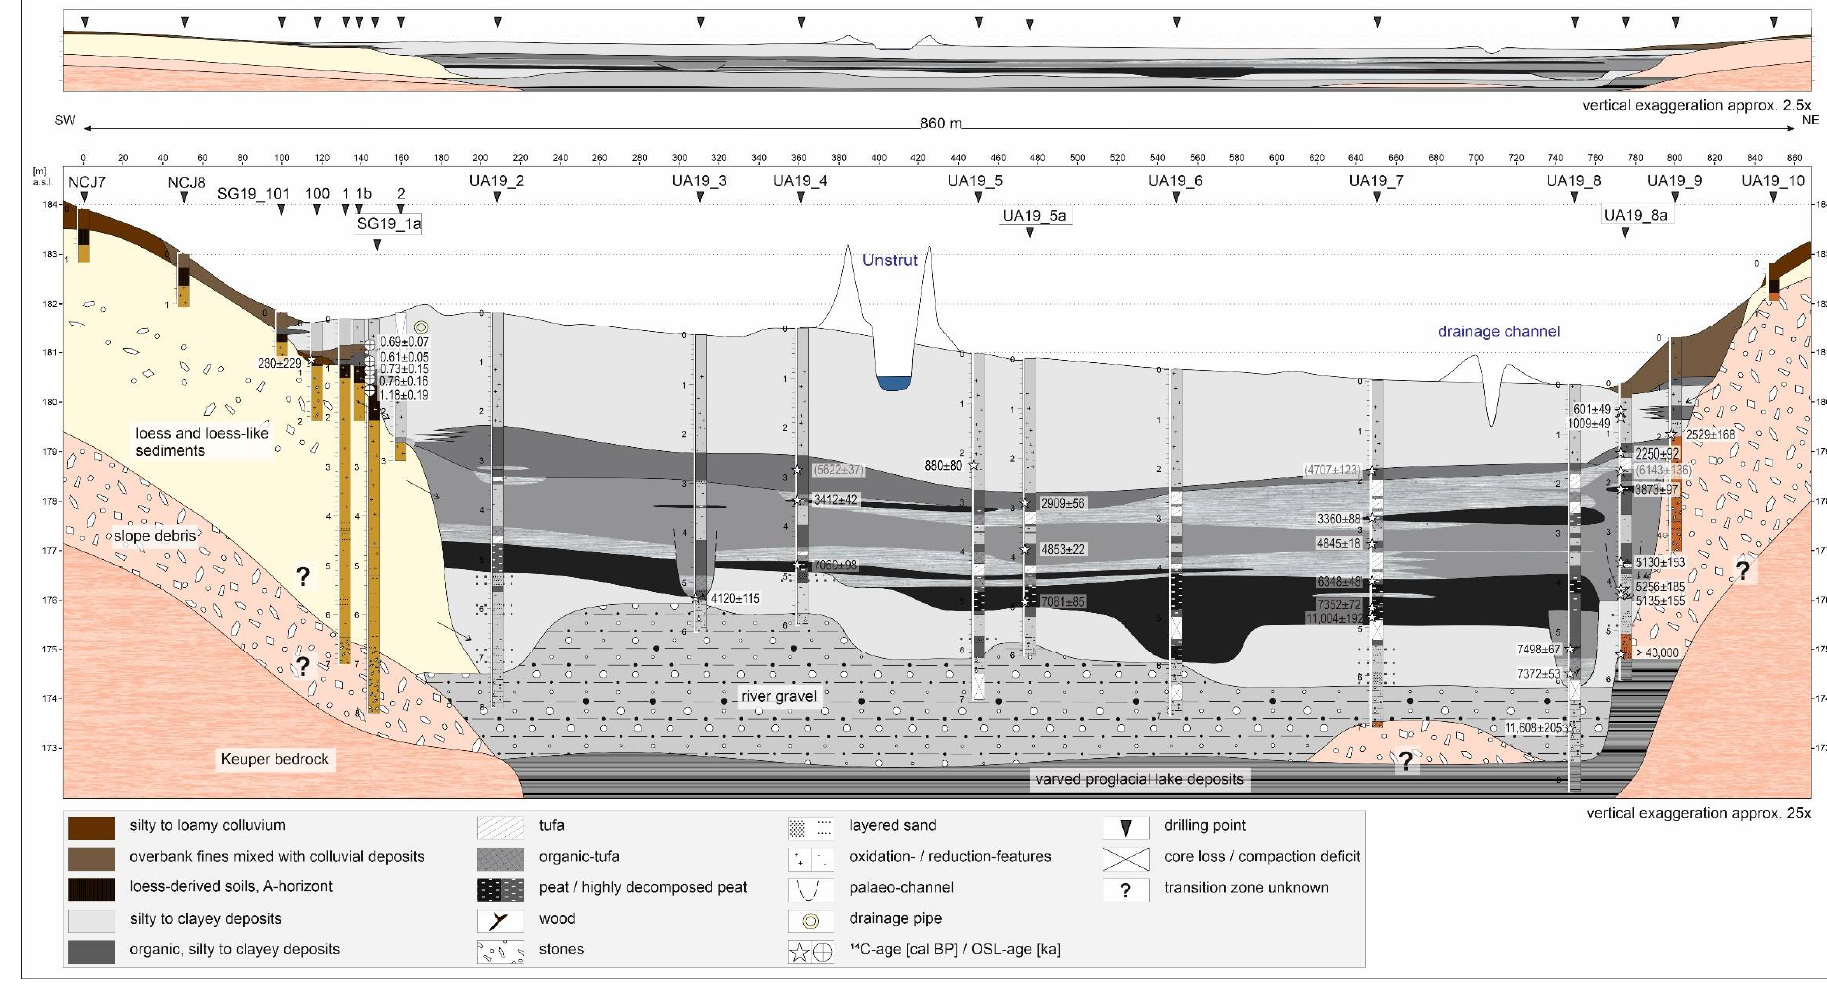
Figure 4. ( Top ) Valley cross-section exaggerated by the factor 2.5 for a more realistic impression of morphological conditions and sediment distribution. ( Bottom ) Valley cross-section exaggerated by the factor 25.